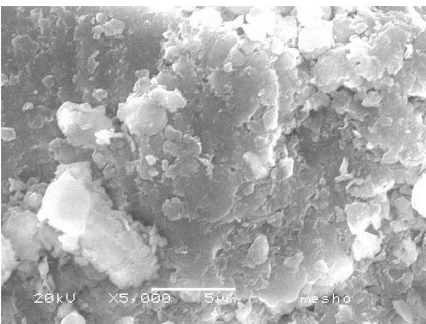
Figure 1: SEM image of the clay sample.